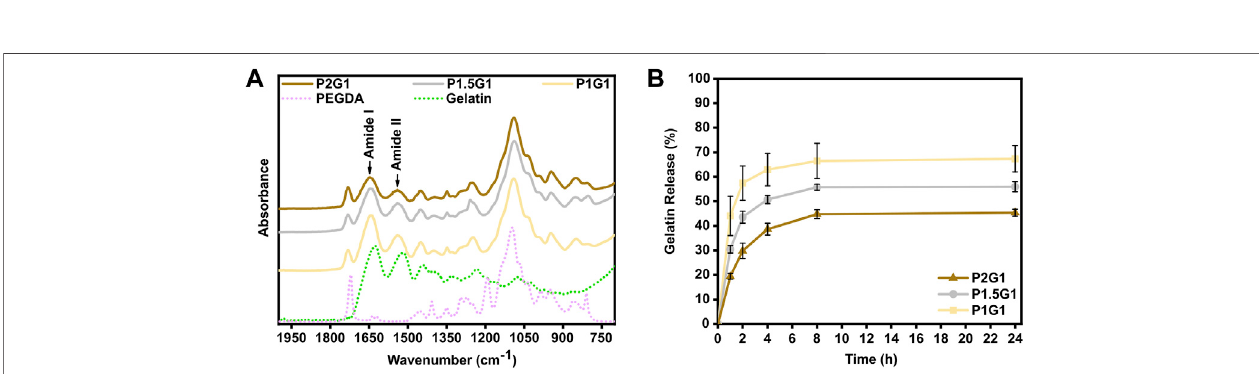
FIGURE 1 | Photopolymerization kinetics of (A) pristine hydrogels at different PEGDA:gelatin ratios and (B) P1G1 hydrogels with different PEDOT:PSS contents. UV irradiation started after 60 s (grey region).